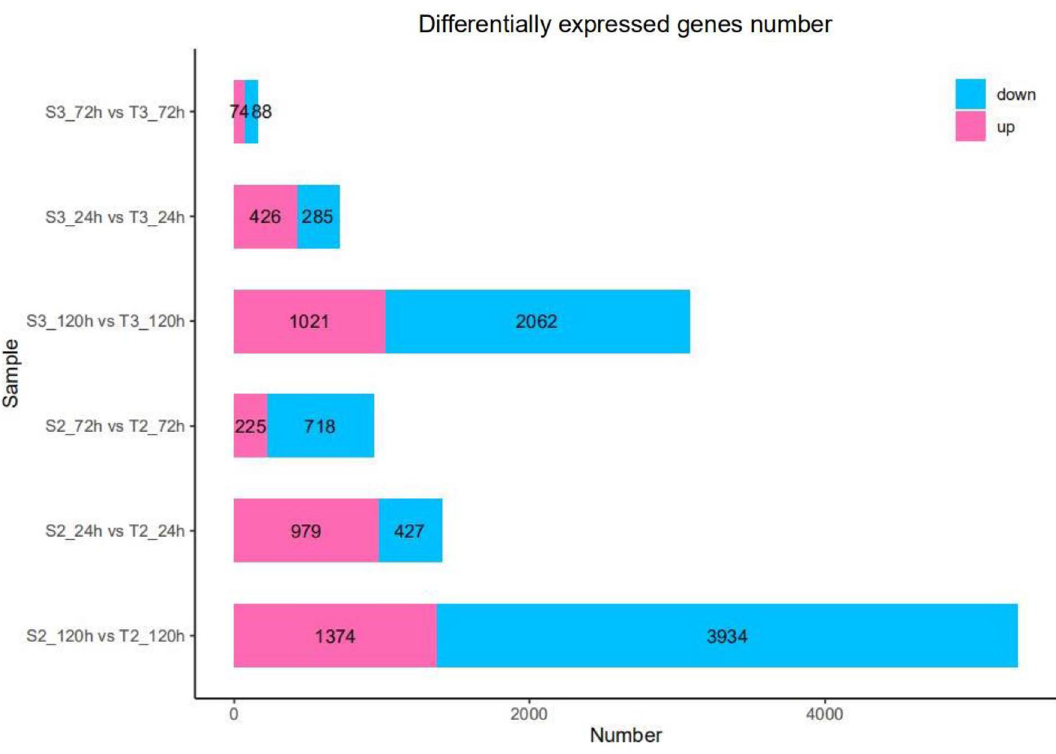
Figure 2. DEGs statistics at different stages of Xinluzao-36 and Zhongzhimian-2 after V. dahliae fungus infection. The up-regulated DEGs are shown in red, while the down-regulated DEGs are shown in blue in the stacked bar